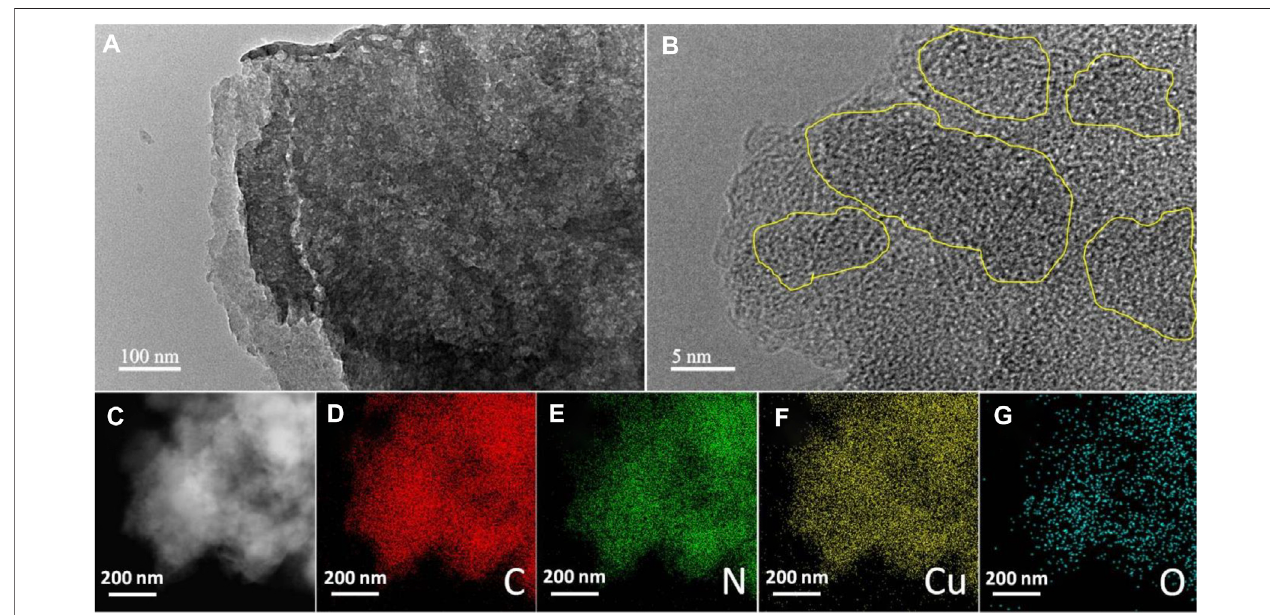
FIGURE 3 | (A) Transmission electron microscopy (TEM) and (B) HRTEM images of 7-%CuO/g-C 3 N 4 , and (C – G) corresponding elemental mapping showing the distribution of C, N, Cu, and O.